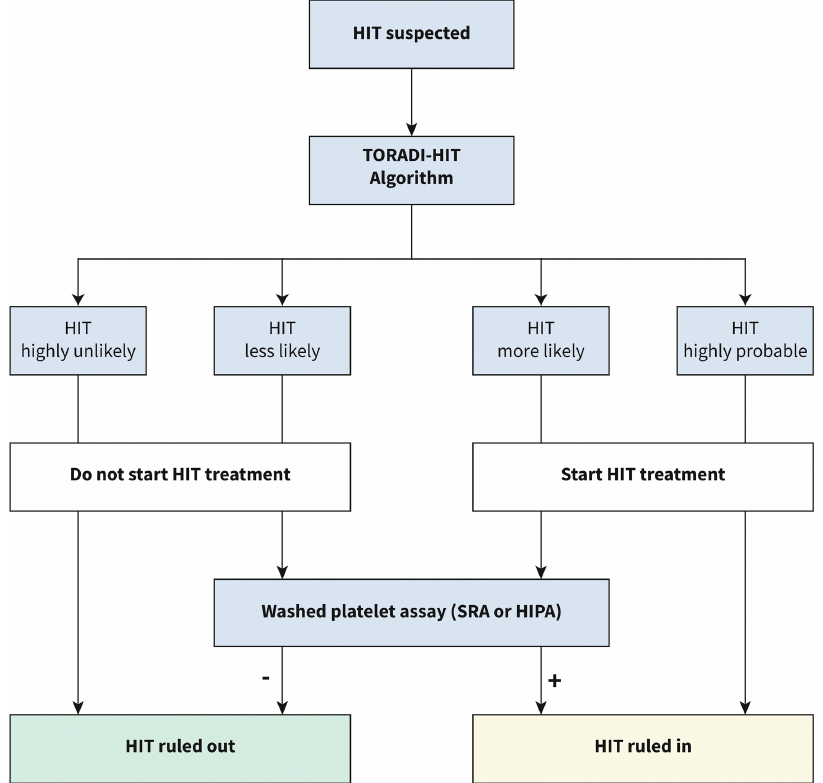
Figure 4. Proposed diagnostic algorithm for heparin induced thrombocytopenia: TORADI − HITP (Nilius, H. et al. 2022) [15].